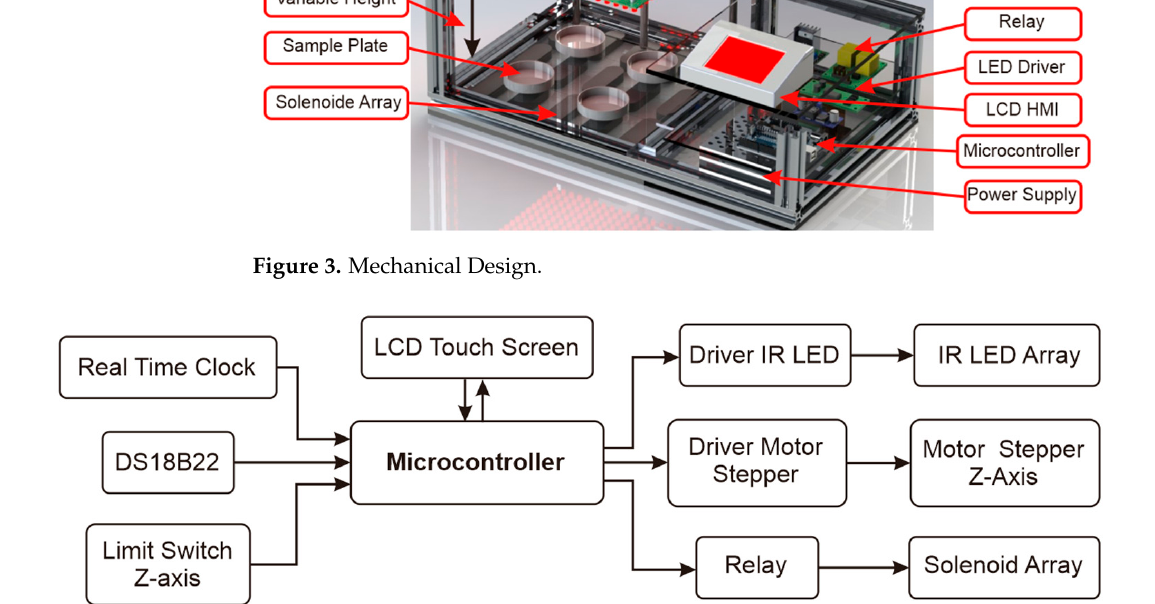
Figure 3. Mechanical Design .